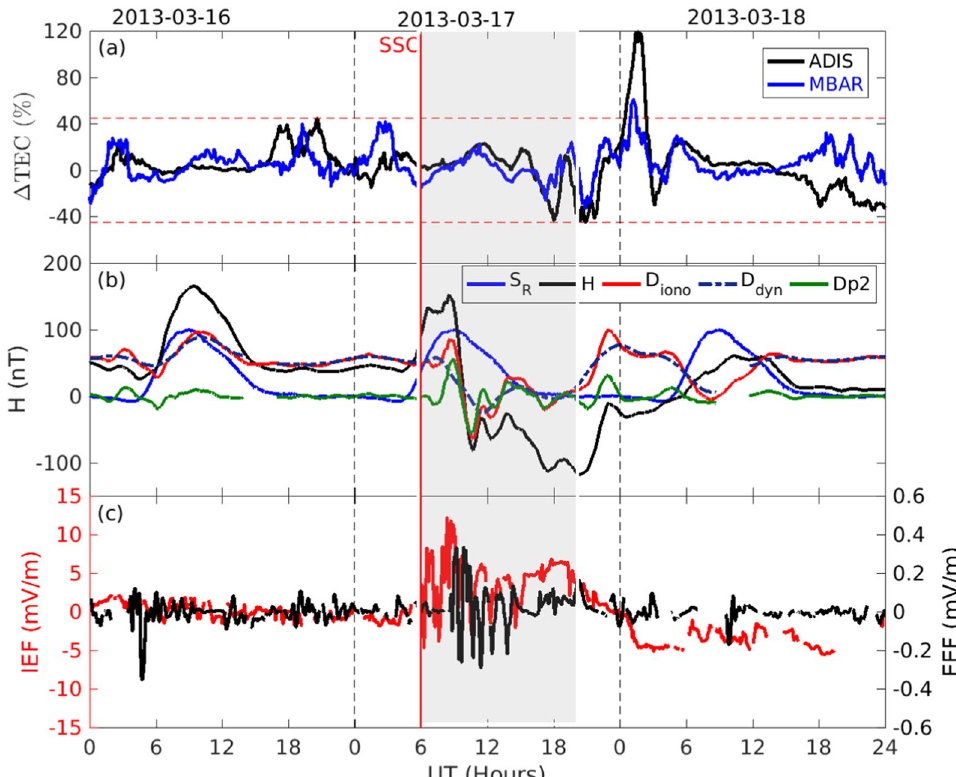
Fig. 3 Temporal variation of ionospheric characteristics, currents and electric fields during the strong geomagnetic storm of 16–18 March